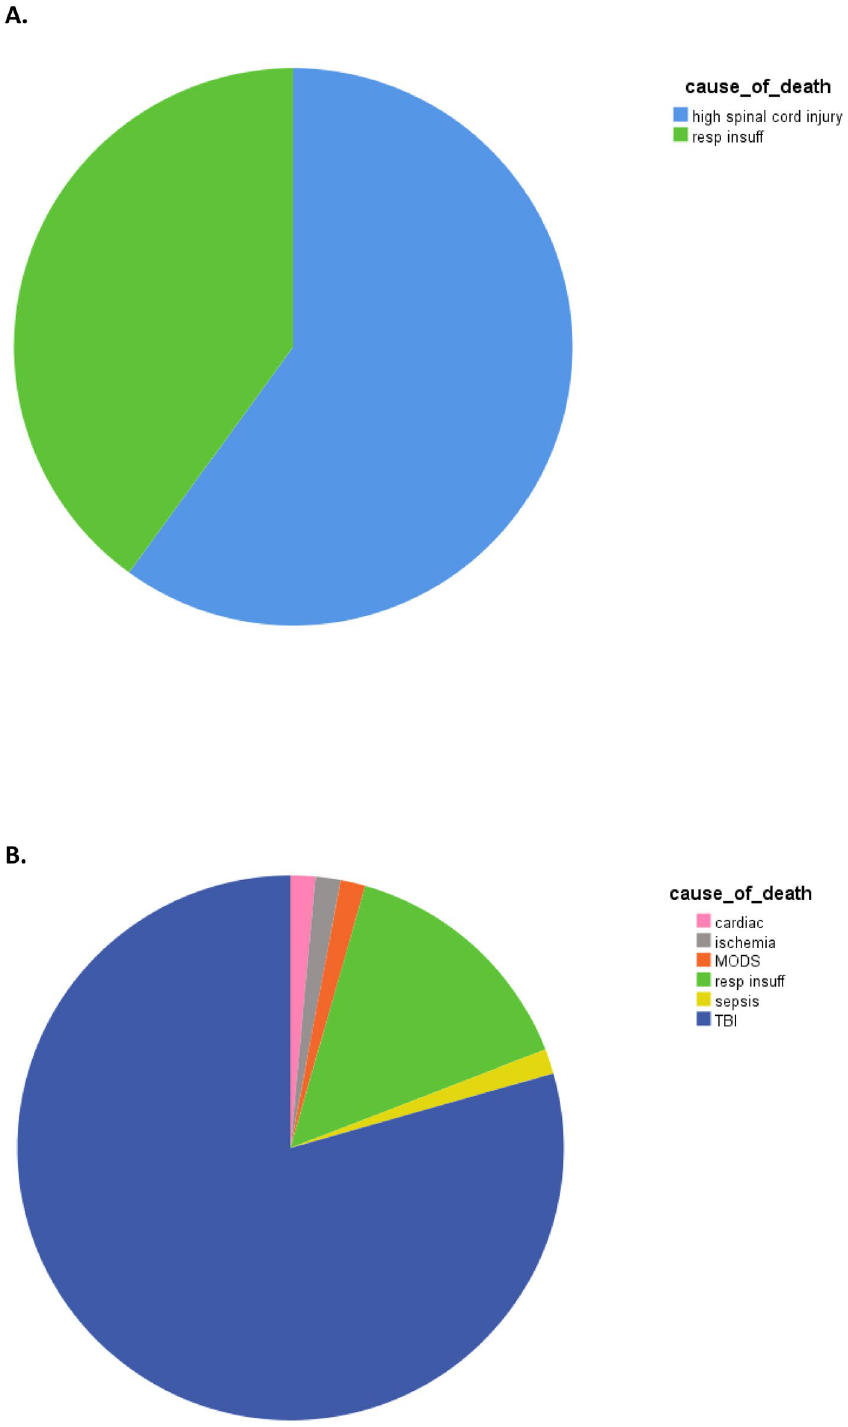
Figure 2. Cause of in-hospital death in polytrauma patients with ( A ) associated severe cervical spine injury, or ( B ) with associated severe traumatic brain